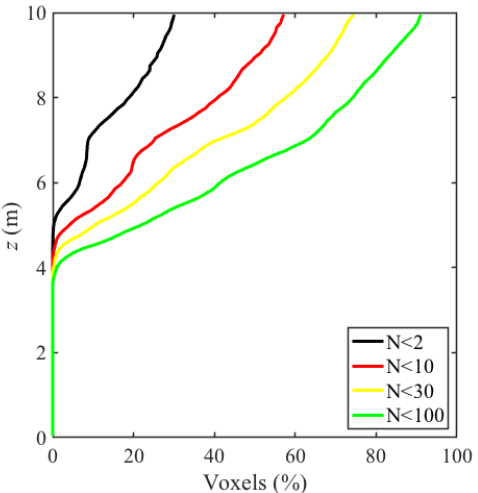
Figure 5. Vertical profiles of percentages of voxels with number of beams smaller than 2, 10, 30, and 100, in the numerical experiment described in Appendix C (five different viewpoints located at 1 m above the ground).